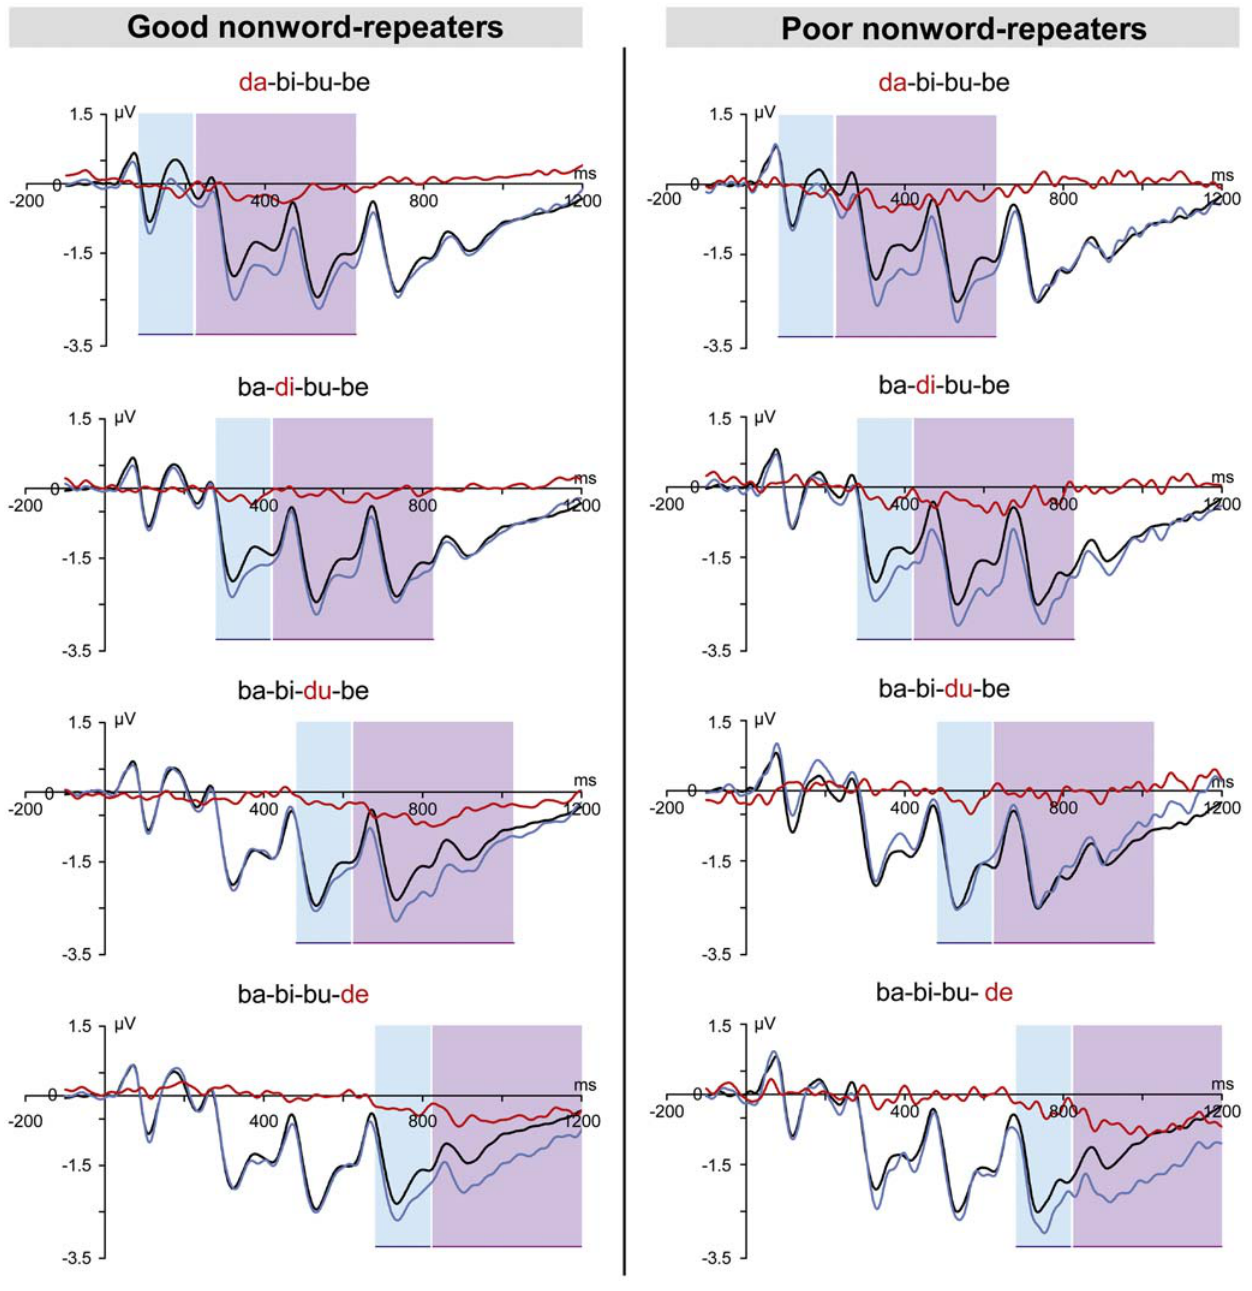
Figure 1. Comparison of grand-averaged ERPS at FZ for the four deviants in relation to the standard. Plots of time (ms) vs ERP amplitude ( m v) for standard (thin blue line) and deviant (bold line) stimuli in relation to position of the deviant syllable as recorded at FZ, for good (left-hand panel) and poor (right-hand panel) nonword-repeaters. The raw difference waveform is shown in red. Each plot is labelled according to the location of the deviant consonant change relative to the standard e.g., ‘ba-bi-bu-be’. The shaded blue area denotes the interval over which the MMN was measured and the pink area the interval for the LDN.